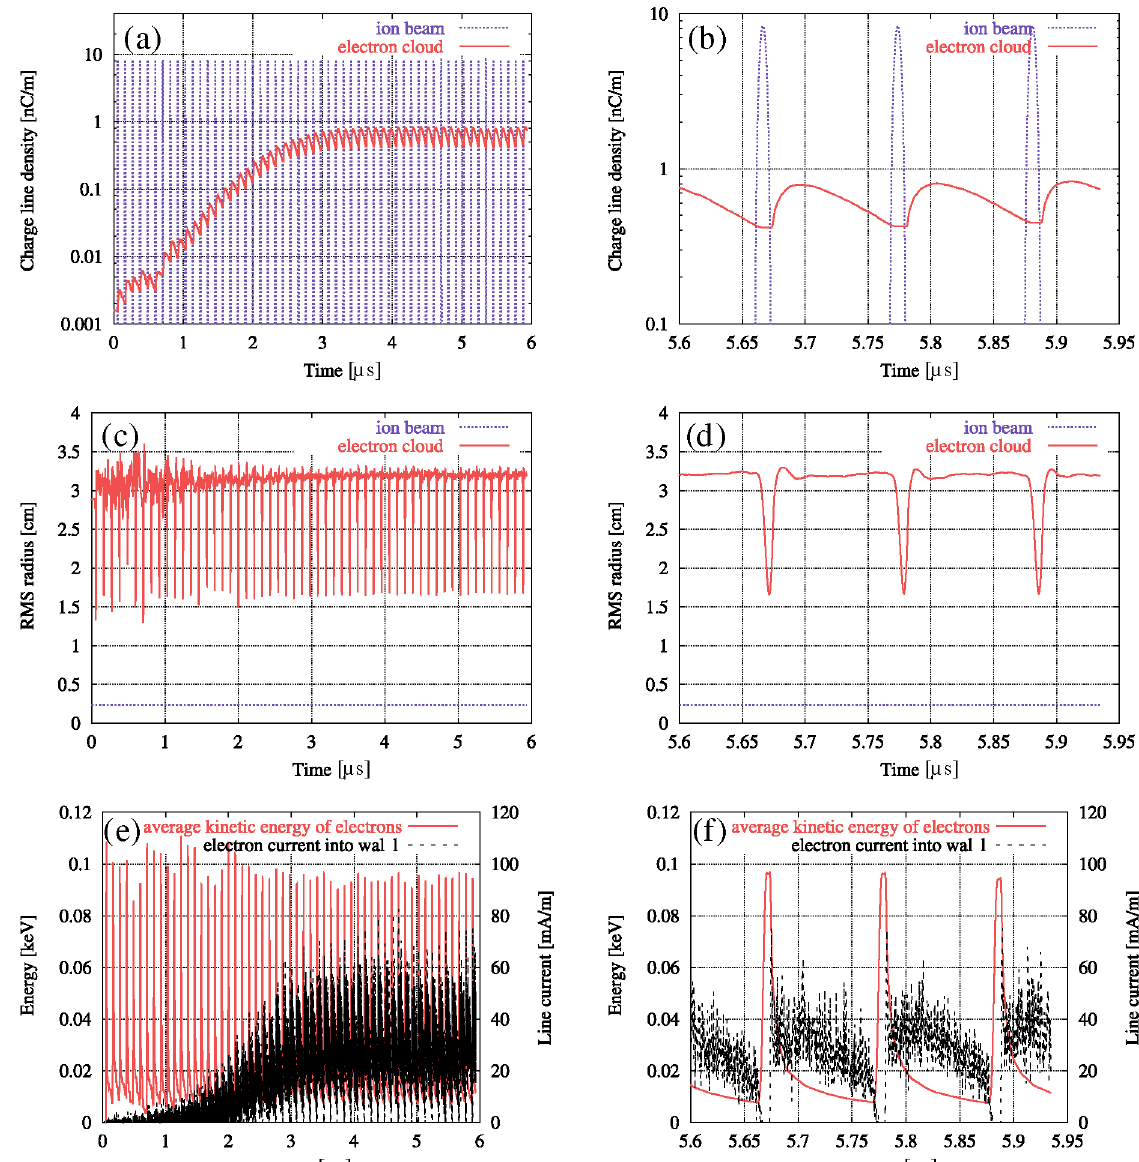
FIG. 5. (Color) Simulation results for the proton reference case. (a) Ion beam and electron cloud line density. (c) rms radius of ion beam and electron cloud. (e) Average kinetic energy of the electrons and current into the beam pipe wall. In parts (b),(d), and (f) the three last bunches from the 55 bunches in parts (a),(c), and (e) are shown,